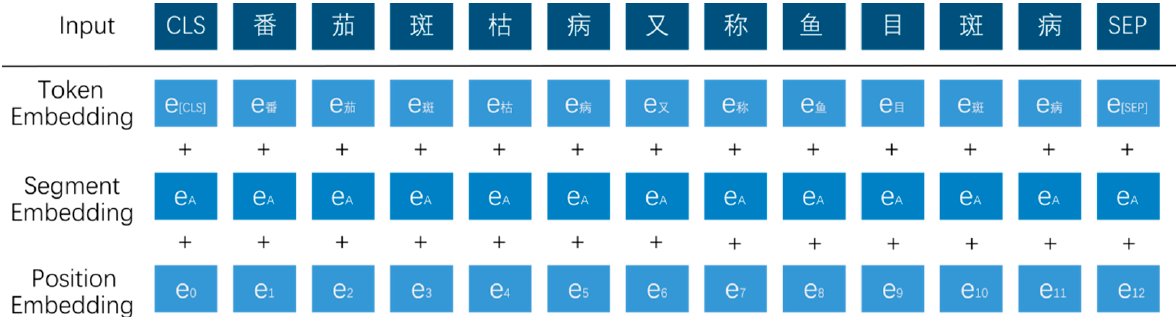
Figure 2. Input representations of the BERT model. Example “ 番茄斑枯病又称鱼目斑病 ” (this means that tomato septorial blight is also known as fish eye spot disease). Note: (CLS) locates the starting position of the sequence; (SEP) identifies the segmentation between sentences; and (ei) represents the embedded features of each character.